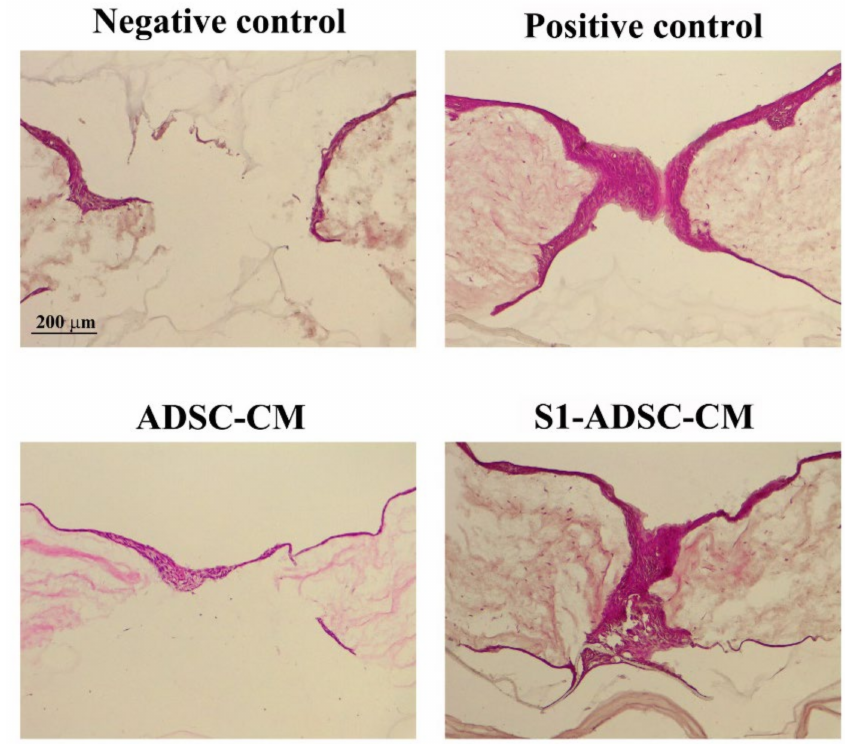
Figure 7. Investigation of S1-ADSC-CM capacity to support wound healing on a human skin organ- otypic model. Hematoxylin and eosin staining showing the healing of the skin organotypic cultures: after 3 days for the samples incubated with DMEM (negative control), DMEM supplemented with 10% serum (positive control), ADSC-CM, and S1-ADSC-CM. Note that both ADSC-CM and S1-ADSC-CM induced the re-epithelialization of the organotypic culture, similarly with the positive